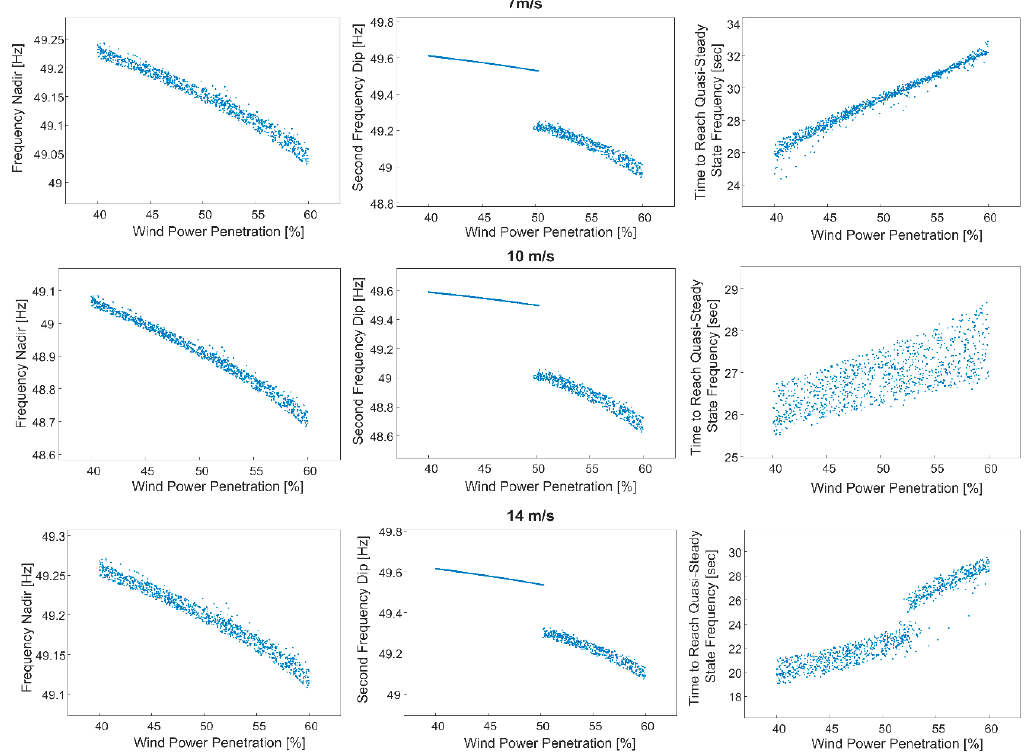
Figure 9. Correlation of objectives (frequency nadir, second frequency dip, time to reach quasi–steady-state frequency) and wind power penetration levels with optimized parameters at 7 m/s, 10 m/s, and 14 m/s wind speeds.